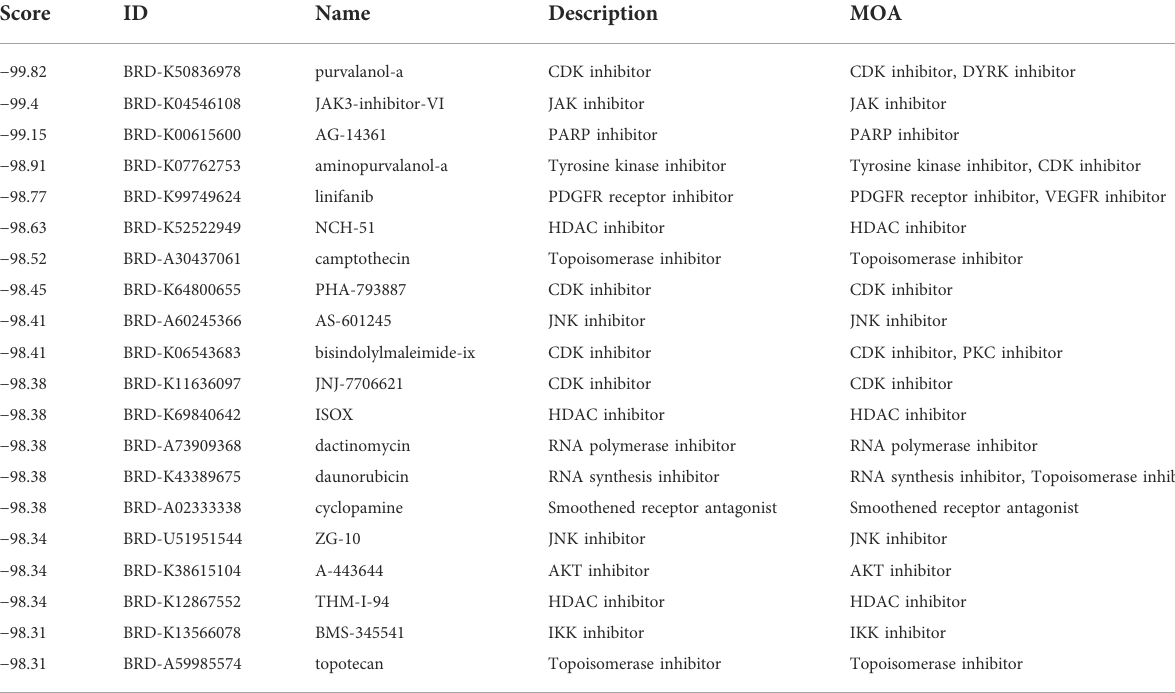
TABLE 1 The top 20 candidate drugs based on the DEGs in the TCGA cohort.